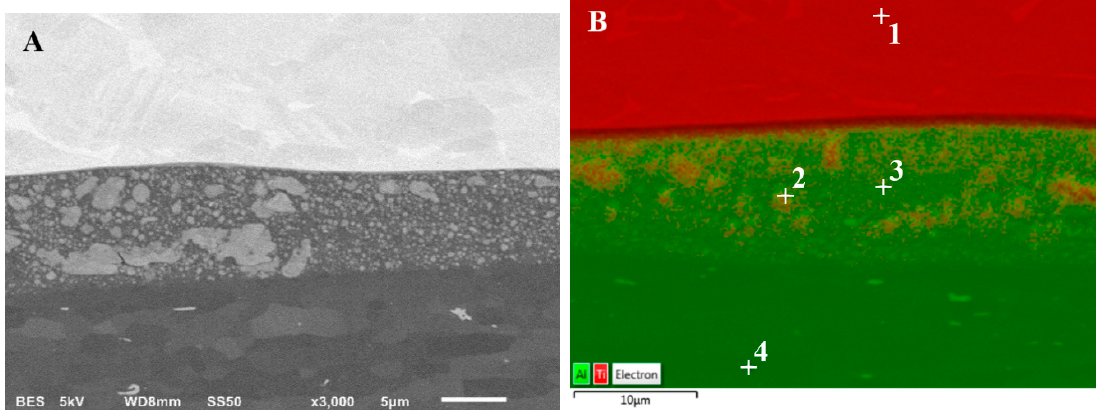
Figure 15. Microstructure of AA1050/Ti6Al4V joint in as-welded state: ( A ) SEM results, ( B ) Ti and Al elements distribution on the sample surface.